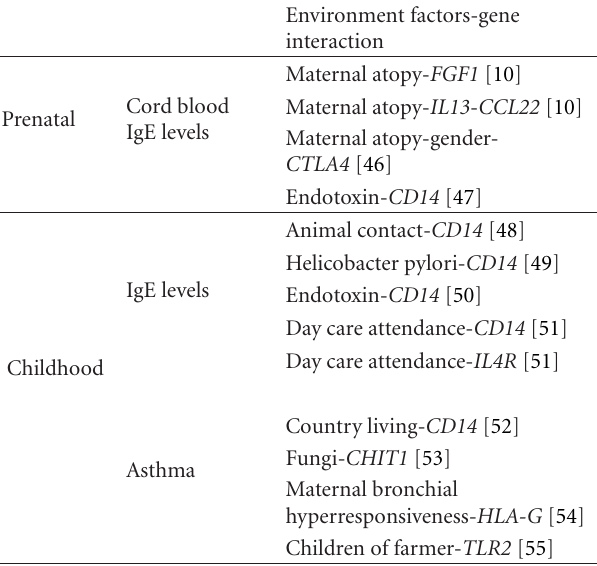
Table 2: Interactions of genes with maternal atopy, endotoxin and other environmental factors on IgE production and asthma